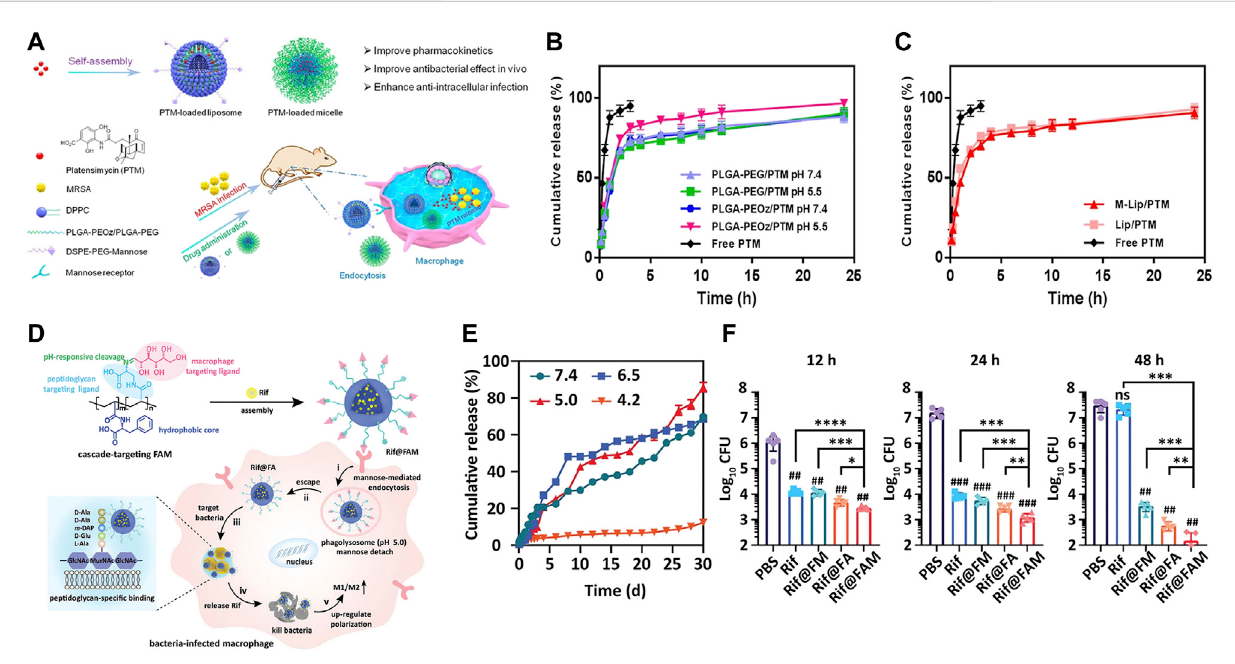
FIGURE 3 (A) Schematic illustration of PTM-loaded liposomes and micelles with pH-responsive release demonstrating a notably high antibacterial ef fi cacy. (B,C) The pH-dependent release characteristics. (D) Schematic illustration of pH-triggered cascade release of rifampicin from DDS to eliminate intracellular MRSA. (E) The pH-sensitive release pro fi le of DDS. (F) The intracellular bactericidal effect of different treatments. Reproduced with permission from Wang et al. (2020) (Copyright 2020 American Chemical Society) and Feng et al.